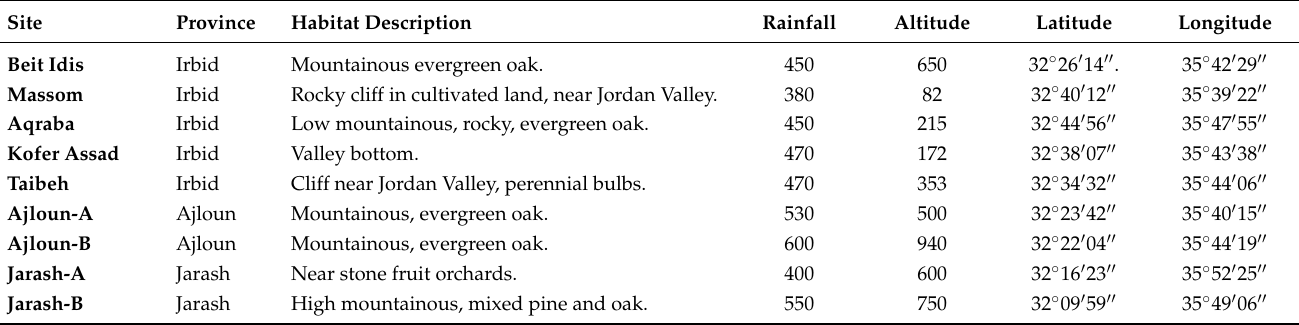
Rocky cliff in cultivated land, near Jordan